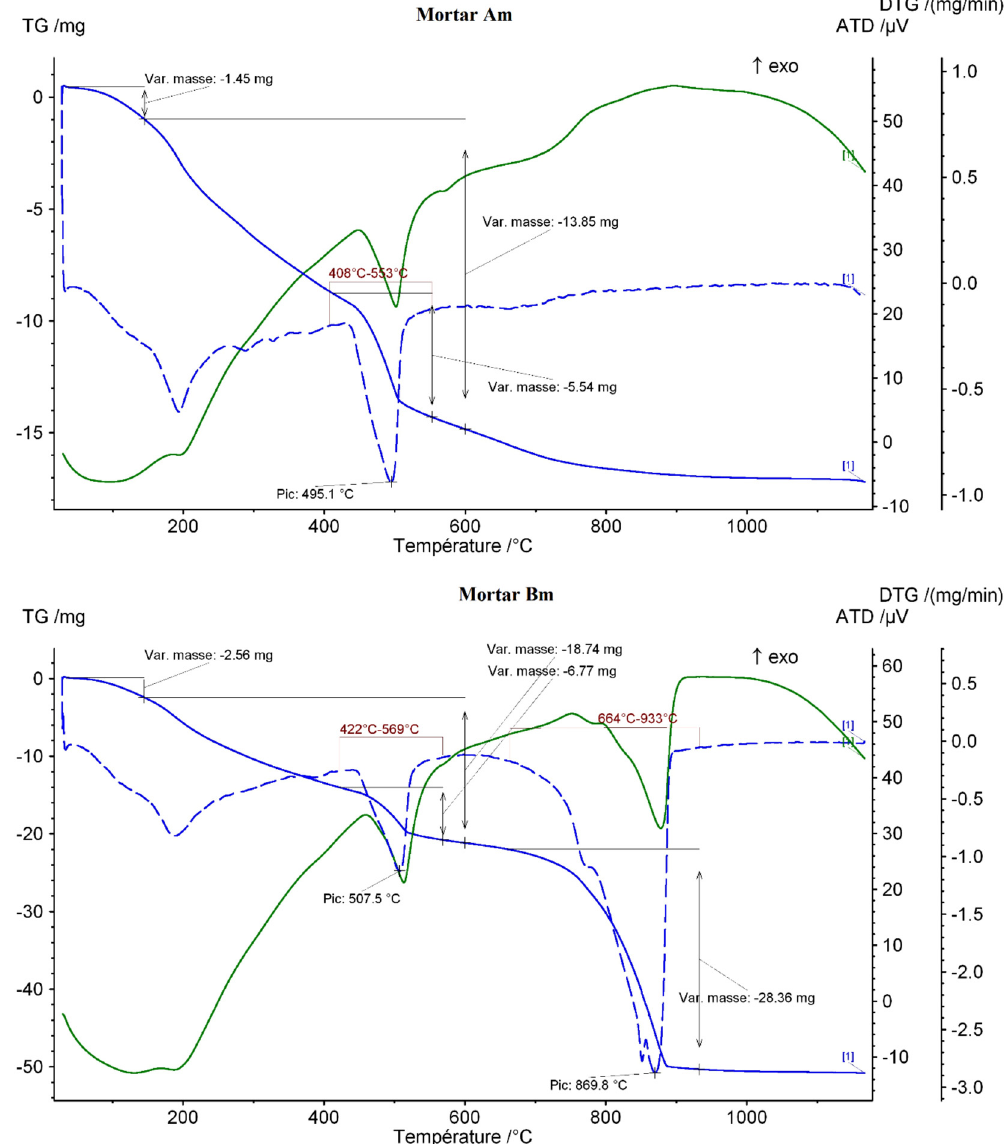
Figure 7: TGA/DTA of the mortars Am and